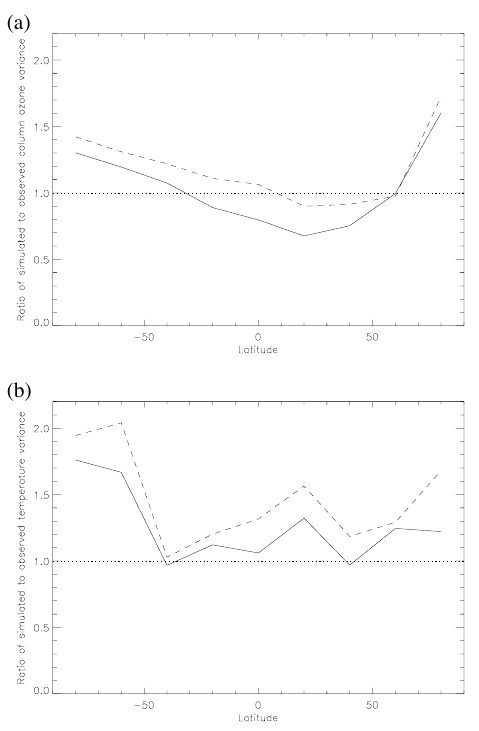
Fig. 2. Ratios of simulated to observed variances in (a) total col- umn ozone and (b) MSU lower stratospheric temperature, as a func- tion of latitude. Solid lines show the ratio of variances of monthly means, and dashed lines show the ratio of variances of annual means. Variances are calculated over the 1979–2005 period without detrending, and simulated variances are taken from the unfiltered ALL (REF-B1) simulations.